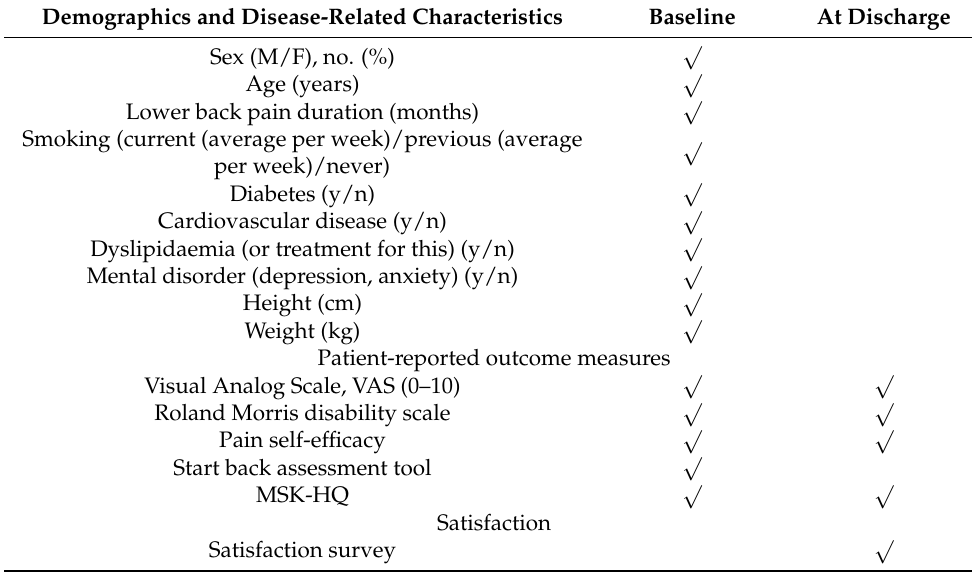
Table 1. Bassline demographics and patient-reported outcome measures. Demographics and Disease-Related Characteristics Baseline At Discharge Sex (M/F), no. (%) Age (years) Lower back pain duration (months) Smoking (current (average per week)/previous (average per week)/never) Diabetes (y/n) Cardiovascular disease (y/n) Dyslipidaemia (or treatment for this) (y/n) Mental disorder (depression, anxiety) (y/n) Height (cm) Weight (kg) Patient-reported outcome measures Visual Analog Scale, VAS (0–10) Roland Morris disability scale Pain self-efficacy Start back assessment tool MSK-HQ Satisfaction Satisfaction